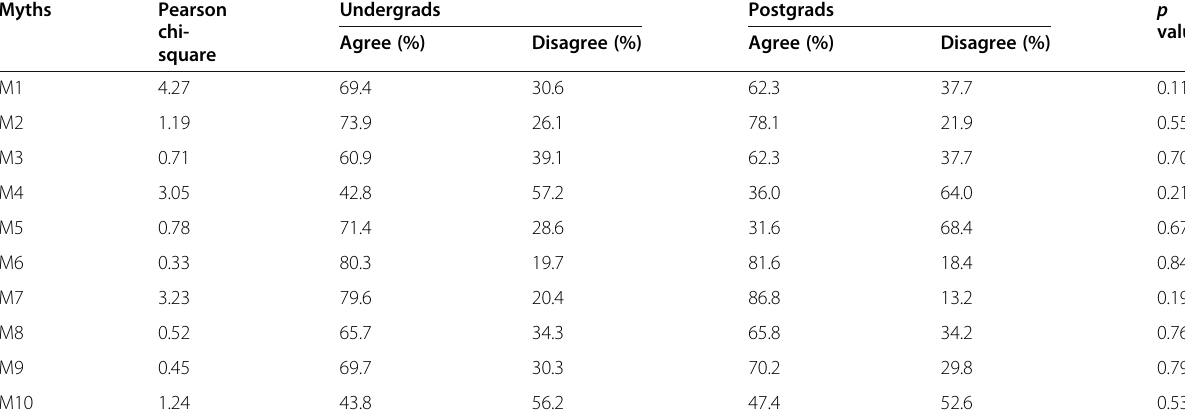
Table 5 Evaluation of the responses based on educational level Myths Pearson Undergrads chi- square